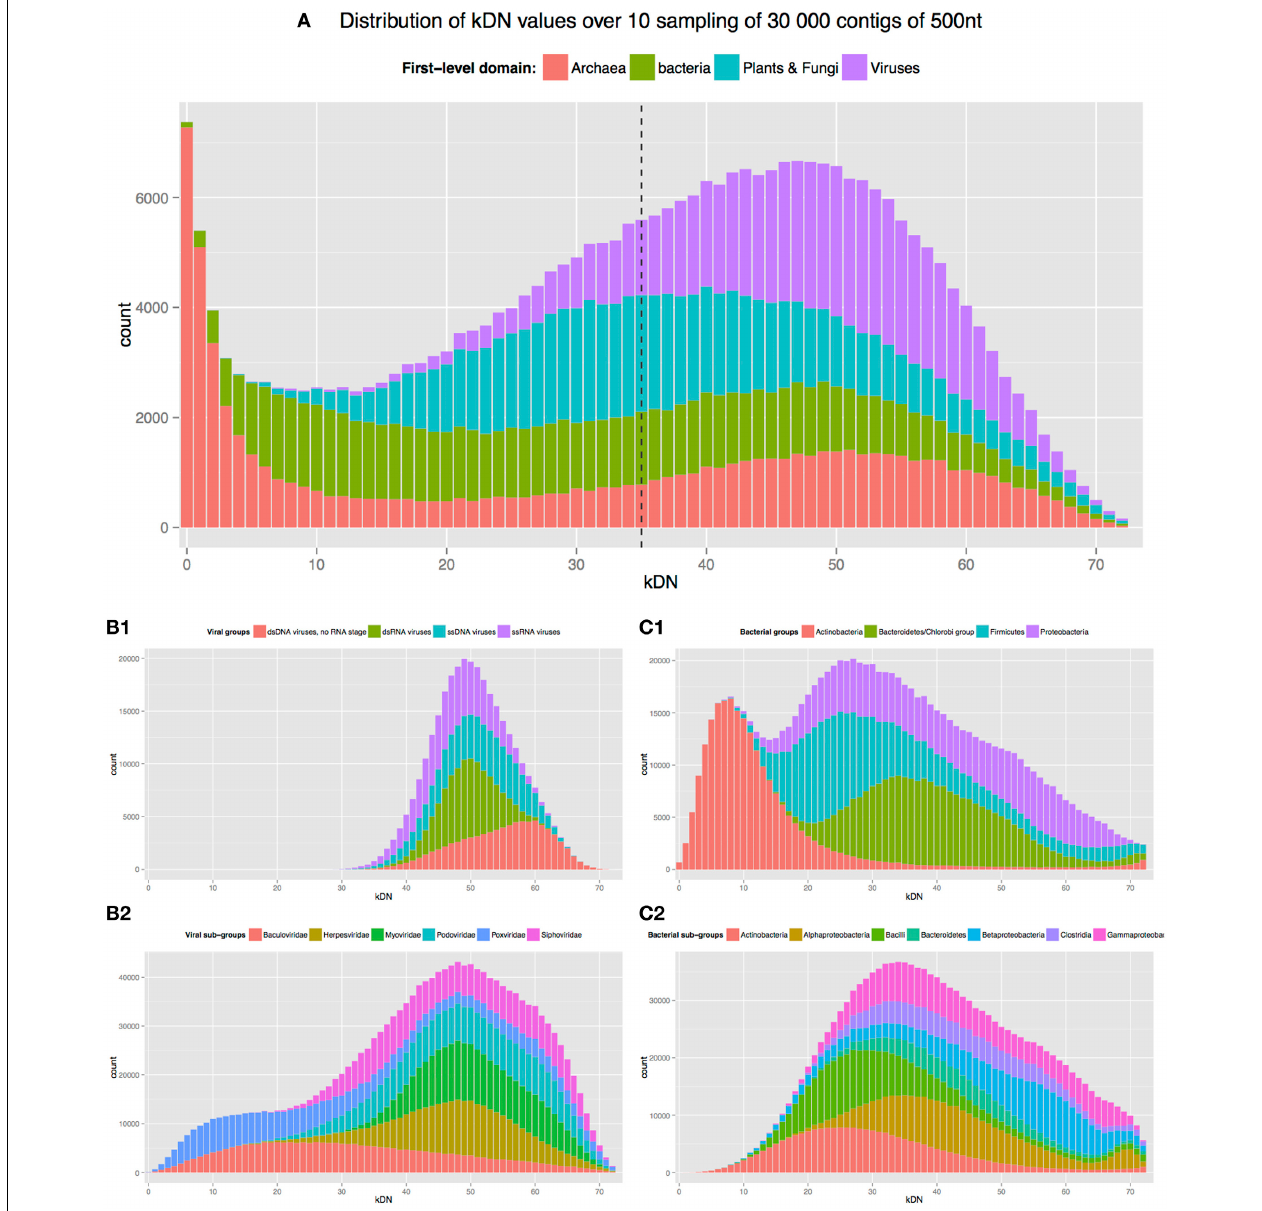
FIGURE 1 | Distribution of kDN by classes for each of three classification tasks. (A) Corresponds to Task 3—assignment of 500 nt contigs to first-level domains; (B1,B2) to Task 2—assignment of 500nt viral contigs to a group or to a family, respectively; (C1,C2) to Task 1—assignment of 500nt bacterial contigs to a phylum or to a class, respectively. Each of the 300,000 randomly selected contigs sampled from different first-level domains were represented as vectors of 3-mer frequencies. Histograms indicate how many contigs (y-axis) per class (colors) have a certain number of neighbors (x-axis) not sharing their own